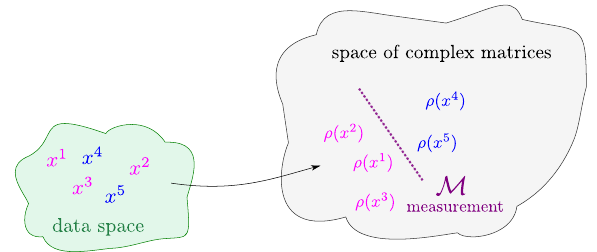
FIG. 2. Many quantum circuits used as supervised machine- learning models can be understood as mapping data to quantum states and then distinguishing these quantum states via hyper- planes defined by measurement observables. Such linear